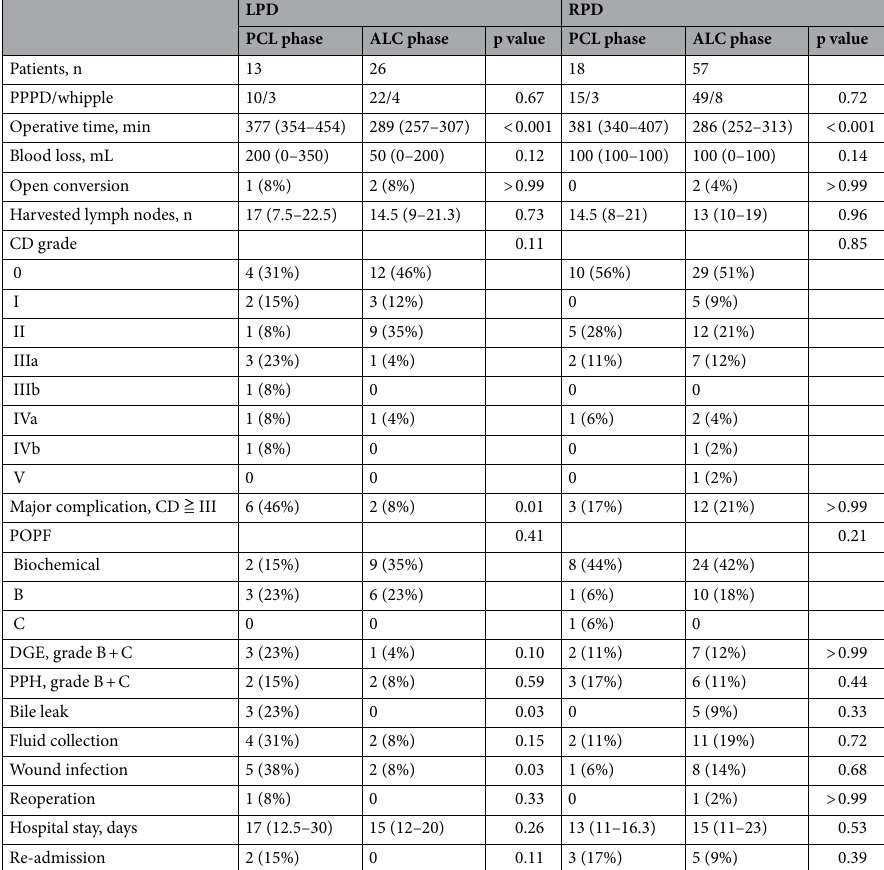
Table 4. Perioperative outcomes between learning curve phases in LPD and RPD. PLC pre-learning curve, ALC after-learning curve, PPPD pylorus preserving pancreaticoduodenectomy, CD Clavien–Dindo,